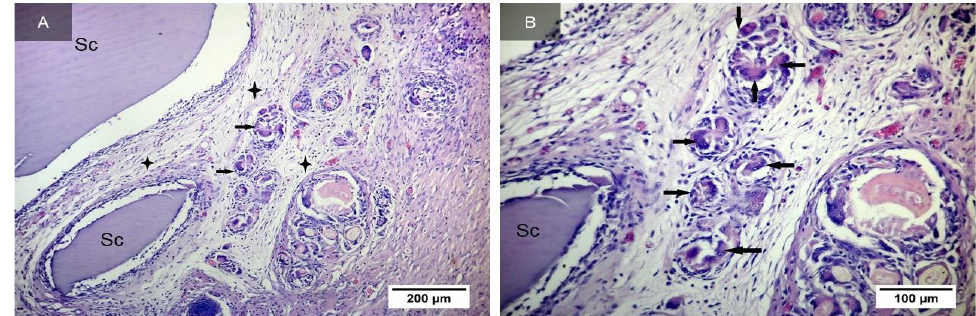
Figure 6. Implant from synthesized GelMA in the subcutaneous tissue of rats after 17 days (indicated by the letters Sc). Connective tissue capsule around the implant (shown with asterisks). Multinucleated macrophages destroying scaffold fragments (shown by arrows). Staining with hematoxylin and eosin. Magnification of the image — ×10 ( A ). Enlarged fragment. Arrows show multinucleated scaffold resorption cells. Staining with hematoxylin and eosin. Magnification of the image — ×20 ( B ).